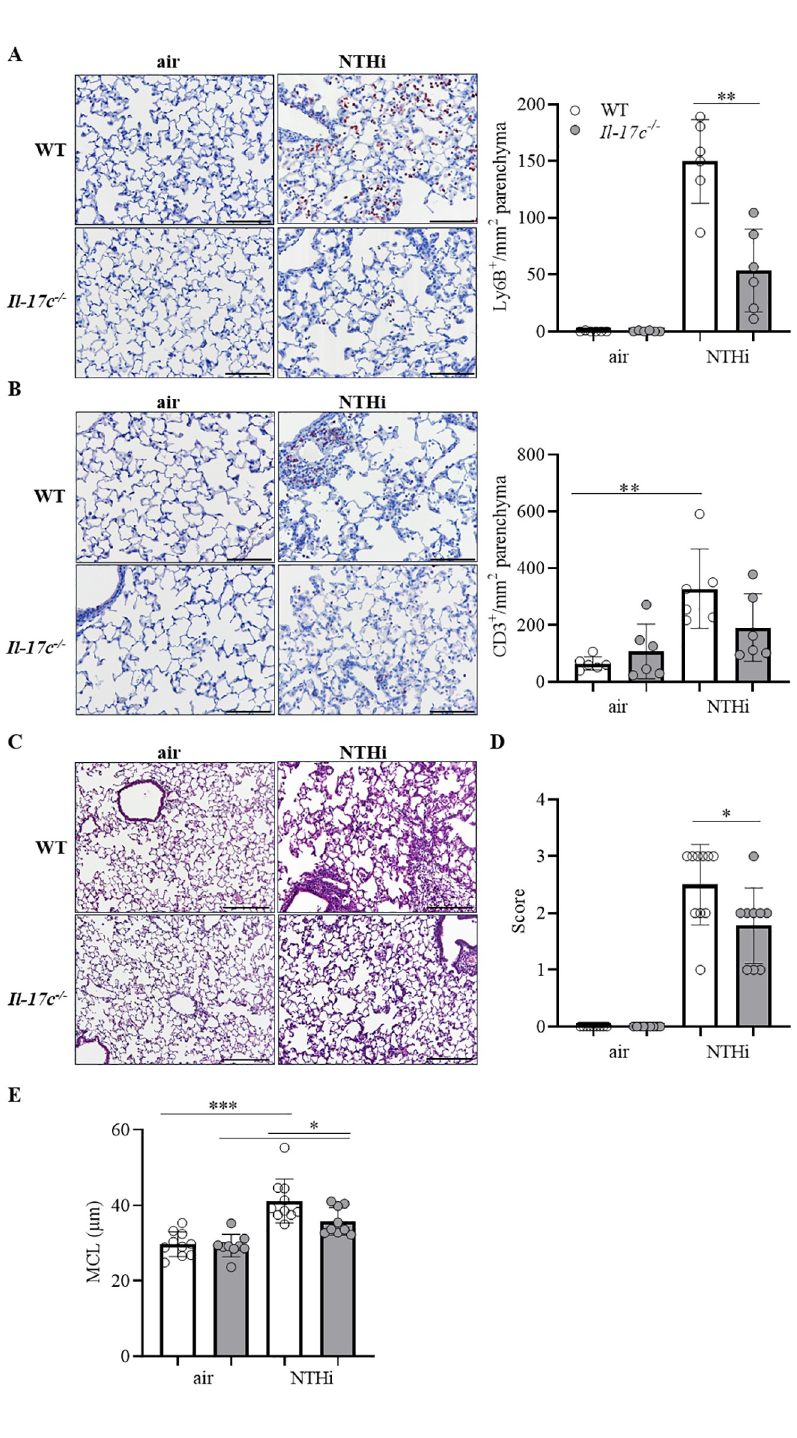
Fig 2. Reduced lung damage in mice deficient for IL-17C. WT and Il-17c -/- mice were exposed to heat-inactivated NTHi three times a week (day 1, 3, 5) for 4 weeks. Mice were analyzed 24 hours after the final exposure to NTHi. Representative IHC of Ly6B (A) and CD3 (B) and quantification of the Ly6B + and CD3 + cells in lung parenchyma (n = 6 mice per group, 6–8 fields per mouse, Scale bar: 50 μ m). Representative lung histology (C, hematoxylin and eosin staining) and inflammatory score (D) (n = 9–10 per group, 2–3 lung sections per mouse, scale bar: 100 μ m). Data